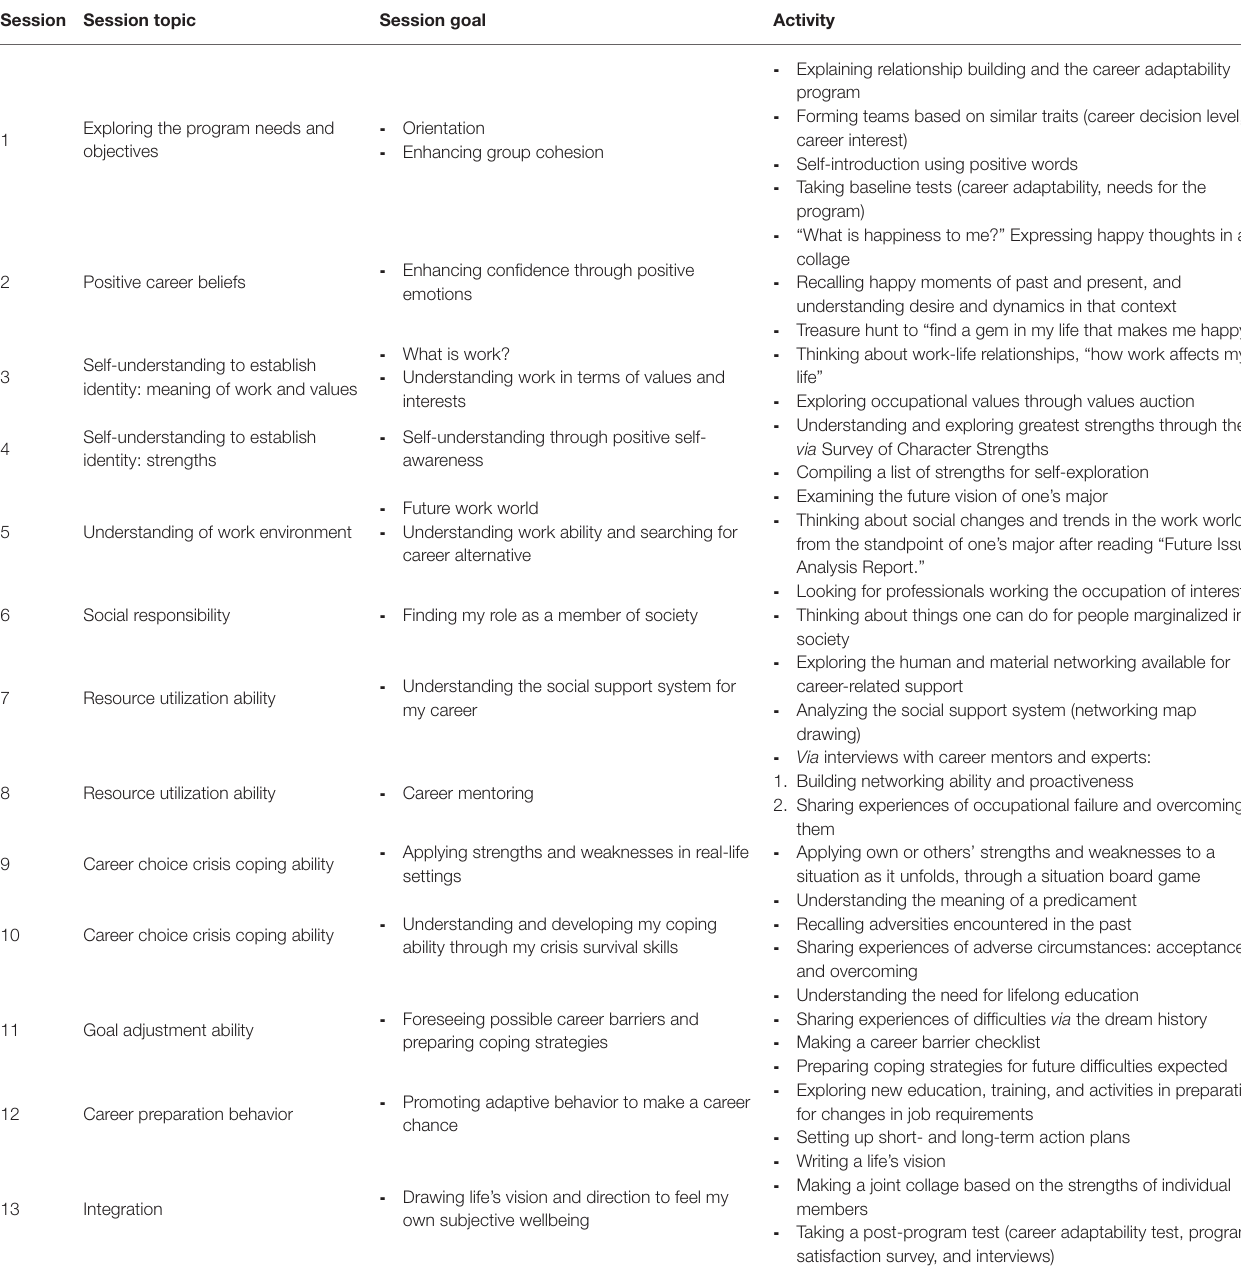
TABLE 3 | The final version of the career adaptability improvement program for undergraduates. Session Session topic Session